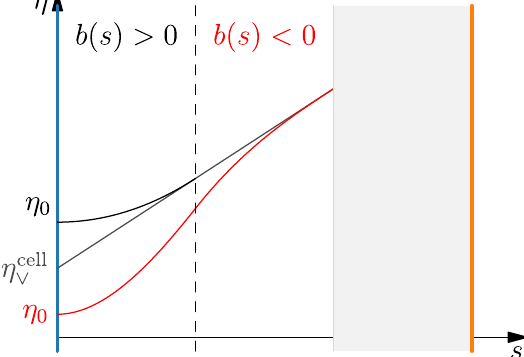
FIG. 10. Behavior of dispersion in an LGB cell for constant β 0 and ϕ < π = 2 (and thus η ∨ > 0 ) with only positive curvature (black) and with alternating curvature (red). The reverse curvature allows η 0 < η ∨ . To keep the total bending angle constant including negative curvature, the overall positive curvature is increased.